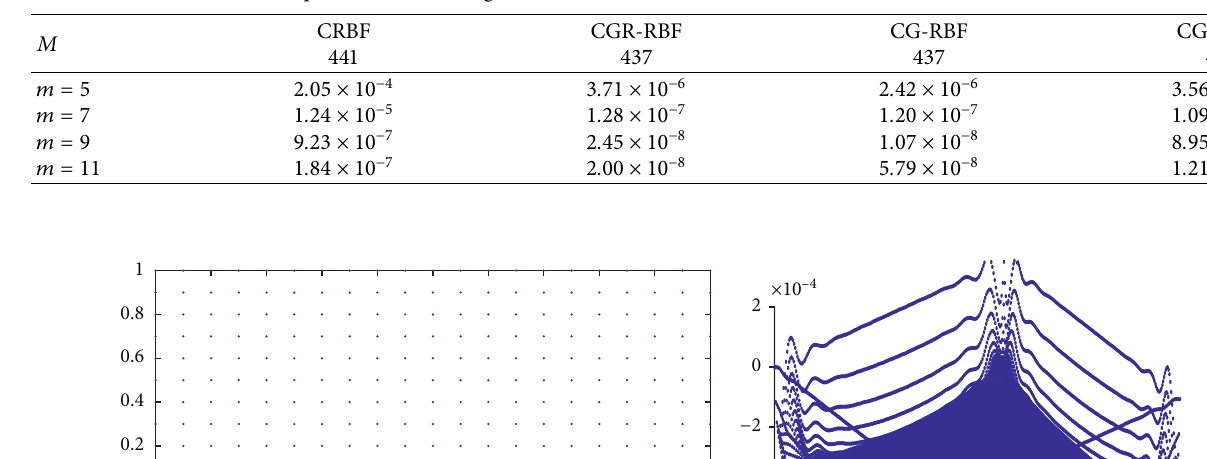
Table 1: Example 1 Relative average errors for the traditional CRBF, CGR-RBF, CG-RBF, and CGL-RBF.